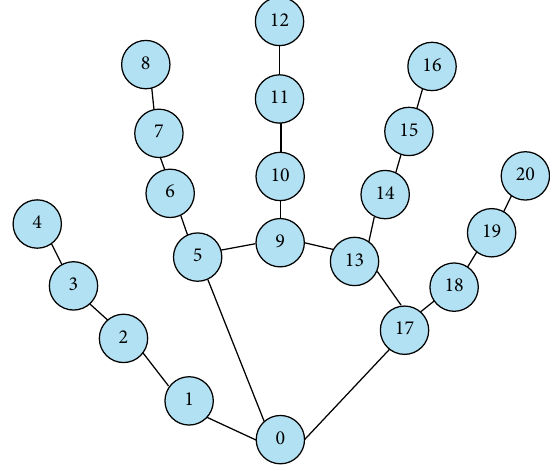
Figure 1: Gesture landmark mapping